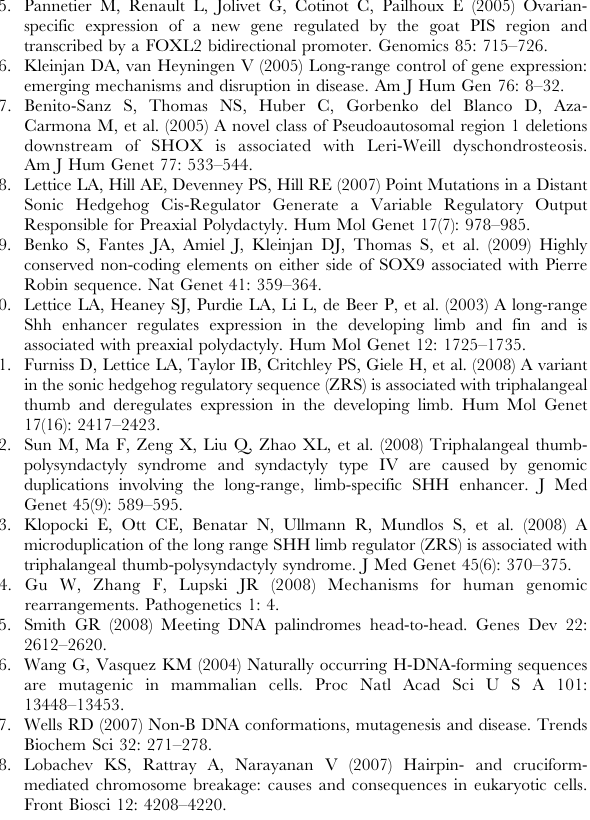
Table S1 Variants identified by sequence analysis of CNCs.